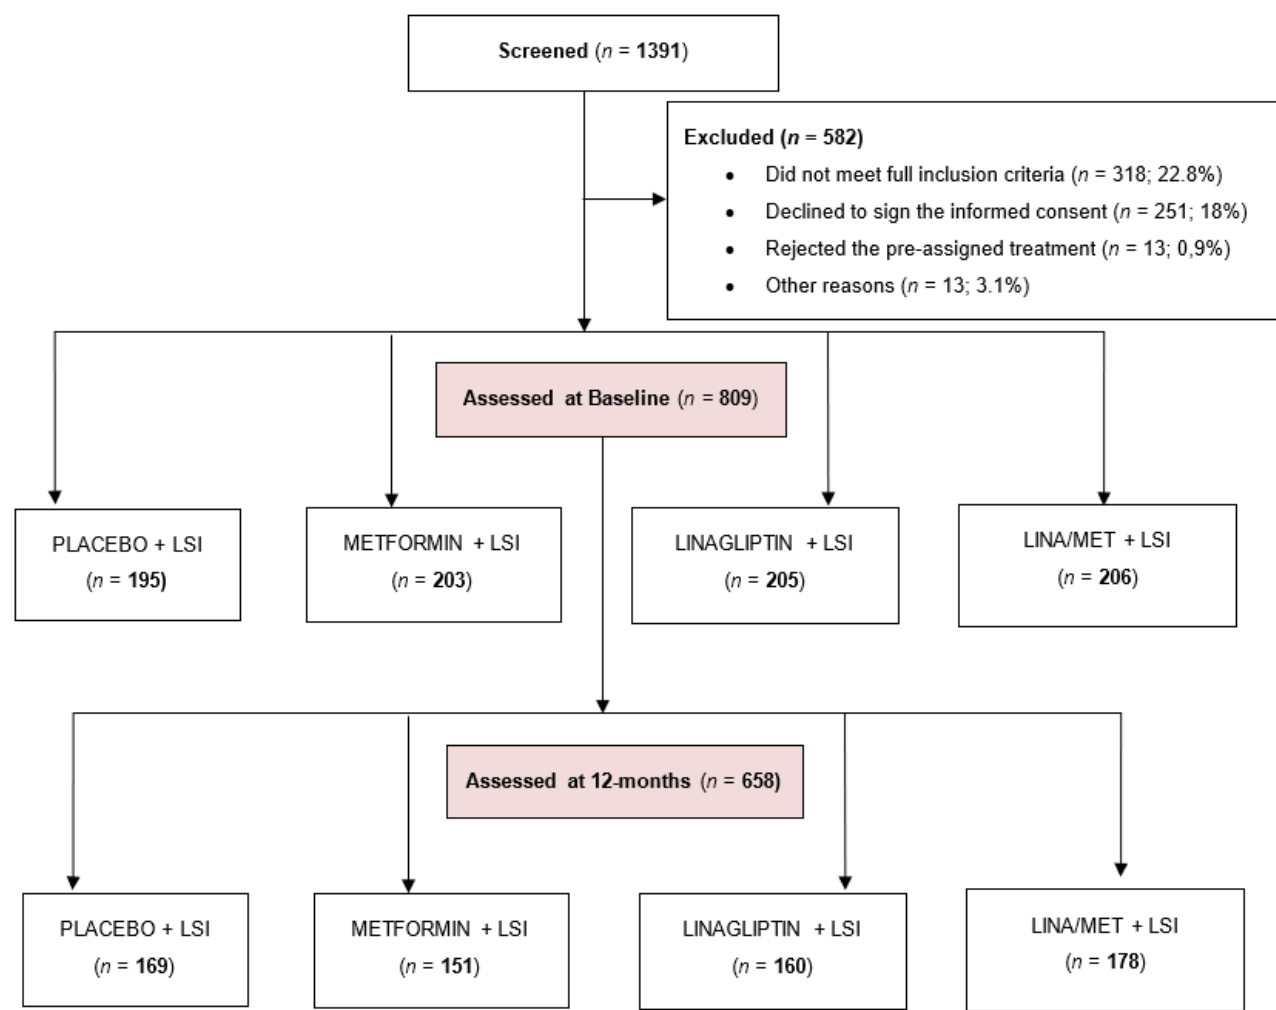
Figure 1. Flow-chart of ePREDICE study population.